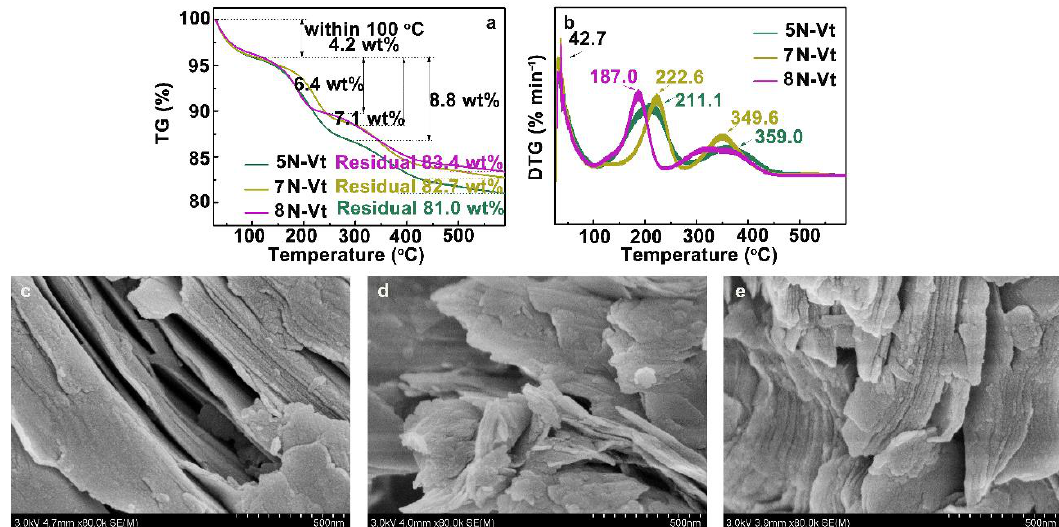
Figure 3. The TG ( a ) and DTG ( b ) curves of organo-Vts and SEM images of 5N-Vt ( c ), 7N-Vt ( d ) and 8N-Vt ( e ).